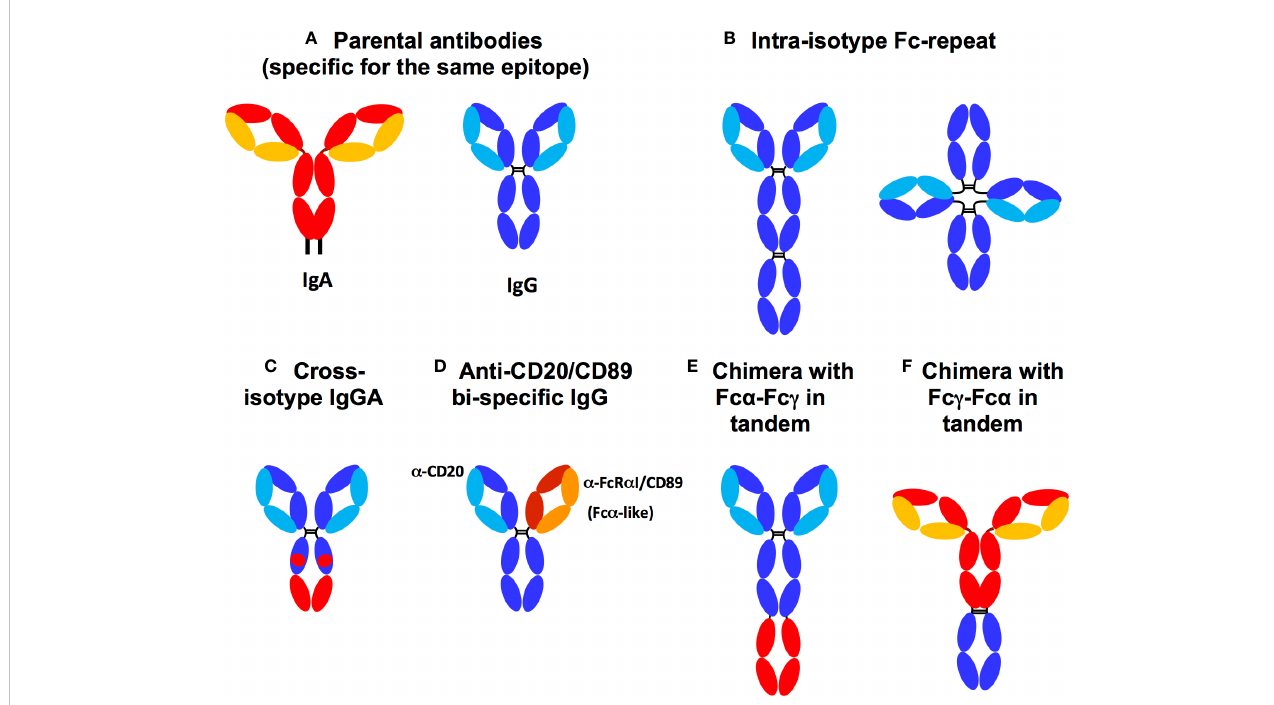
FIGURE 4 Fc chimera and parental antibodies. (A) Parental IgA (HC: red, LC: yellow) and IgG (HC: dark blue LC: light blue). (B) Fc g duplication (dark blue) in tandem or tetrahedral form, (C) Cross-isotype IgGA harbouring a hybrid of Fc g (dark blue) and Fc a (red), (D) Anti-CD20 and Fc a RI/CD89 bi-speci fi c IgG isotype. The chimera can bind both to FcR via its authentic and to Fc a RI/CD89 via the anti-CD89 that replaces Fc a used in other constructs. (E) Chimera with Fc a -Fc g expressed in tandem. (F) Chimera with Fc g -Fc a expressed in tandem. Both Fc g -Fc a and Fc a -Fc g chimeras can harbour either an IgA2 hinge, a linker (G4S)4 or an IgG1 hinge between the two Fc